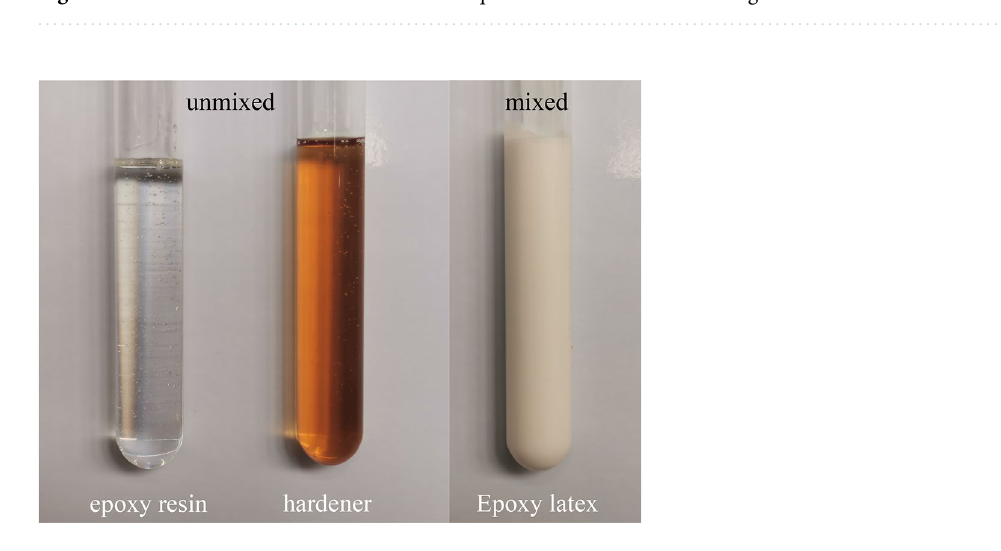
Figure 3. Images of epoxy latex materials before and after